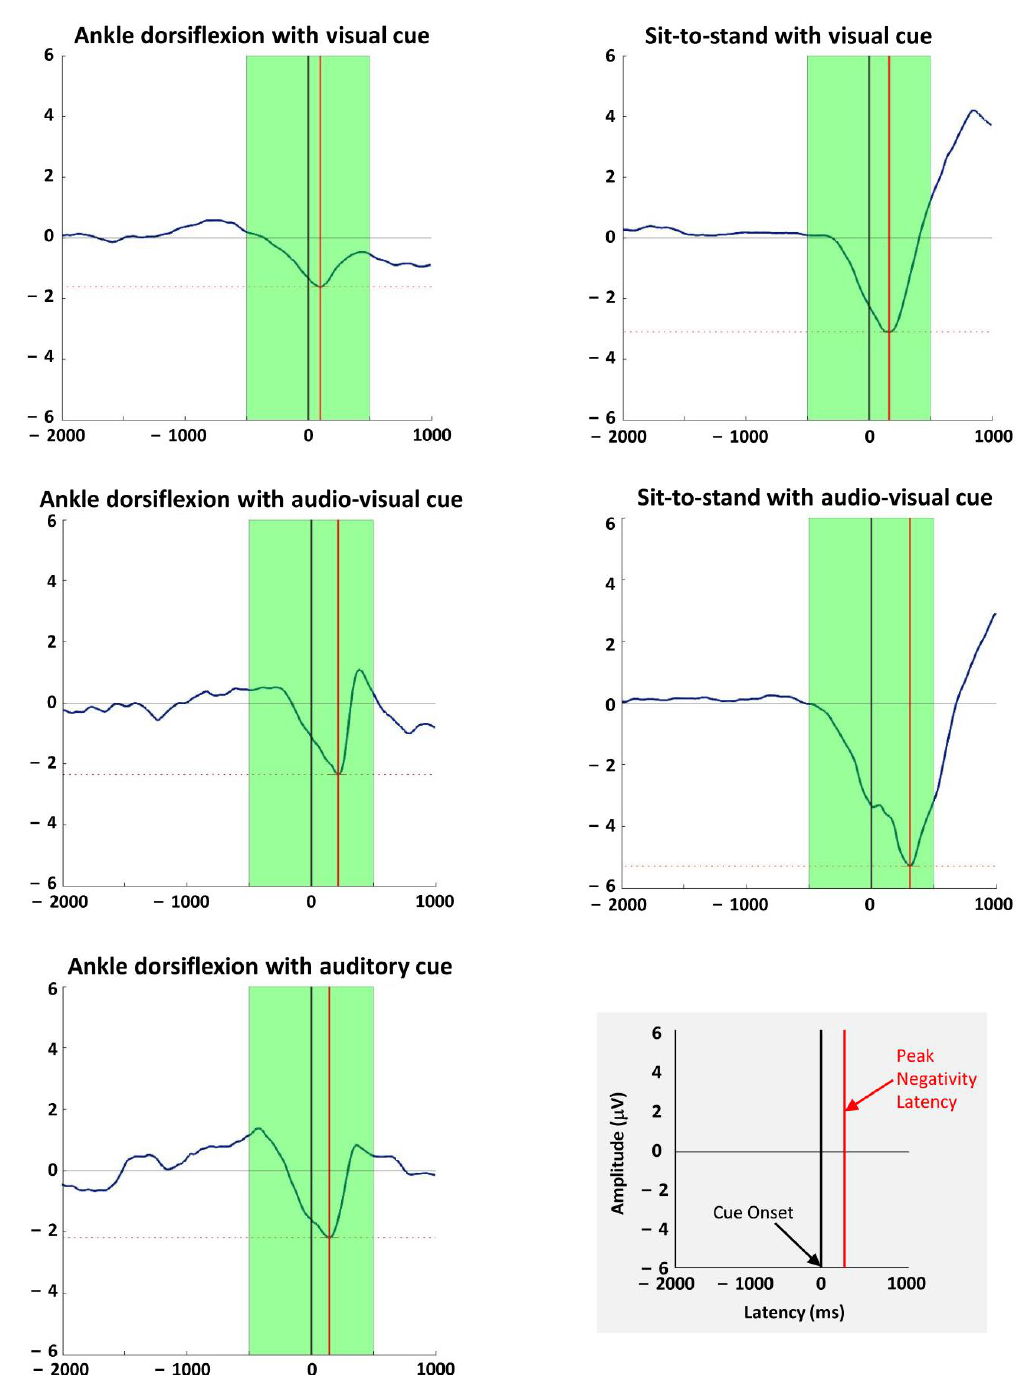
Figure 2. Grand-average CNV waveforms for each movement condition for all participants (n = 27).